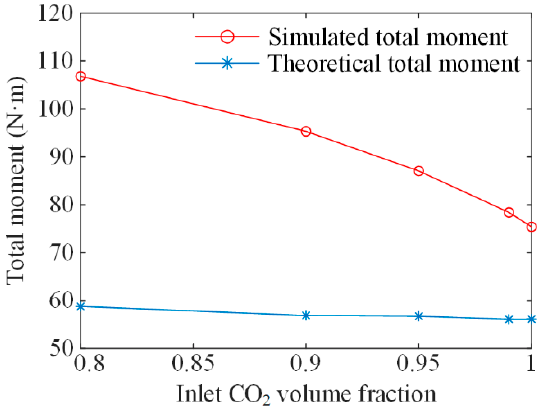
Figure 16. Theoretical and simulated total moment of the Roots pump under different inlet CO 2 volume fractions.